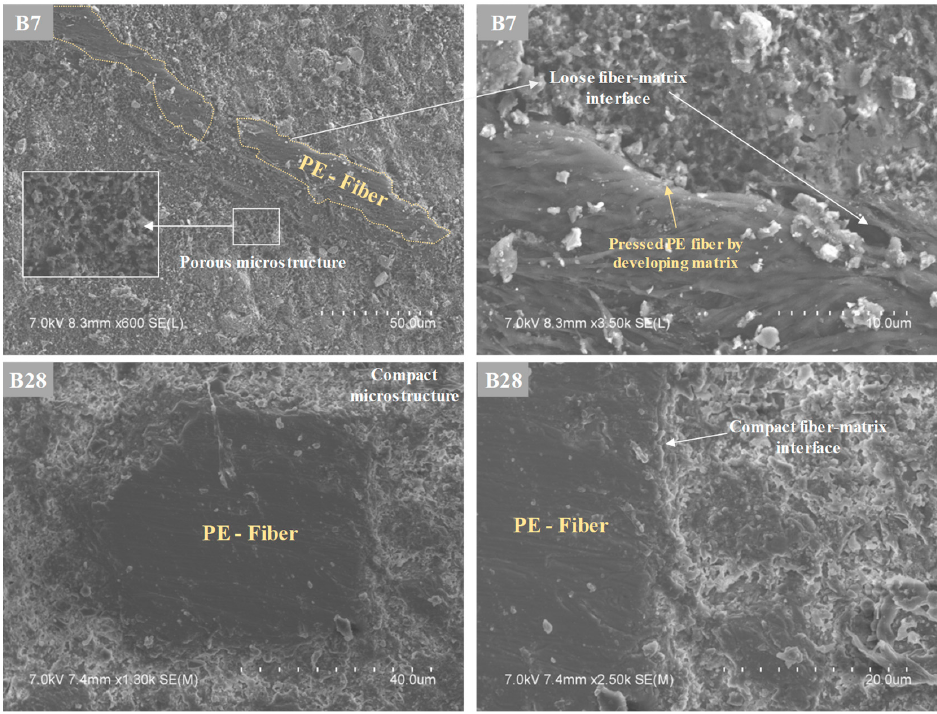
Figure 6. SEM images on the microstructure of specimens D7 and D28.